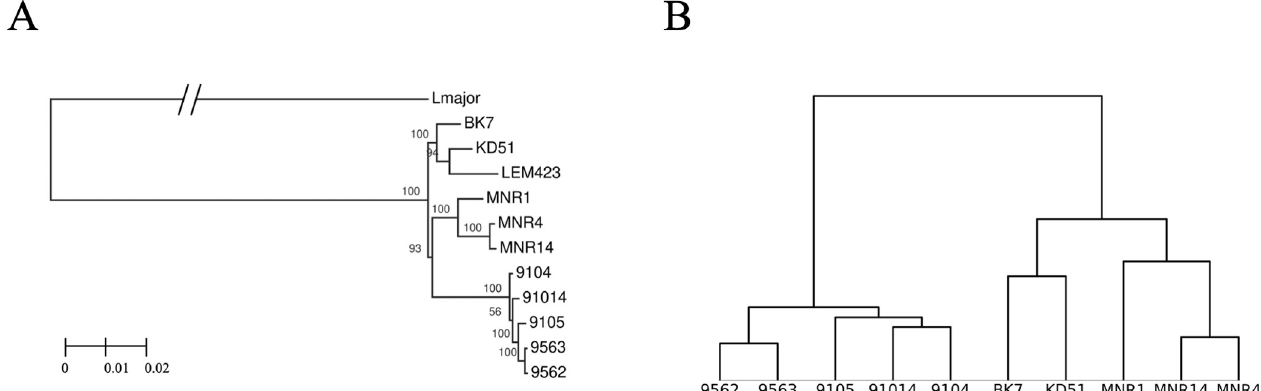
Fig 2. Phylogenomic analyses of L . turanica strains. (A) Maximum-likelihood phylogenomic tree of the investigated strains. Leishmania major is used as an outgroup. Bootstrap supports were determined using 1,000 replications. Branch length leading to L . major is manually scaled down 15 × times as inter-species distance is much higher than that for strains of the same species. The scale bar represents substitutions per site. (B) Hierarchical clustering distance matrix output. All 81,551 confident homozygous SNPs were used to calculate the distance matrix.